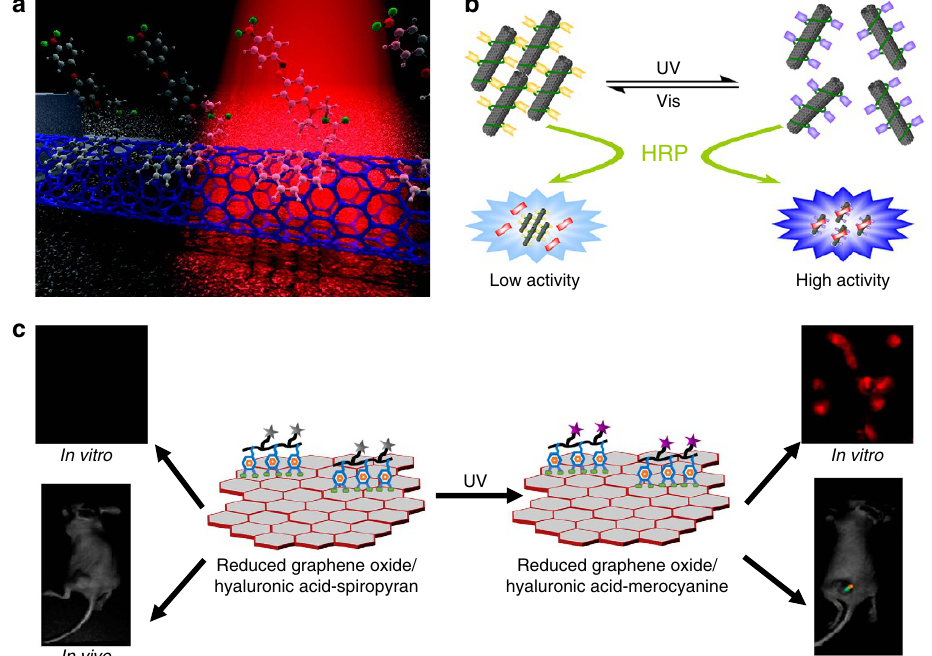
Figure 5 | Applications of photochromic carbon-based nanomaterials in sensing (upper images) and biology (lower image). ( a ) CNTs modified with azobenzenes were used as a color detector. Reproduced from ref. 100 (Copyright 2009 American Chemical Society, http://pubs.acs.org/doi/pdf/ 10.1021/nl8032922). ( b ) Spiropyrans covalently attached to CNTs were used to regulate horseradish peroxidase (HRP) activity via light irradiation. Reproduced from ref. 110 (Copyright 2011 Royal Society of Chemistry). ( c ) rGO/hyaluronic acid-spiropyran used for in vivo fluorescence imaging. Adapted from ref. 114 (Copyright 2013 American Chemical